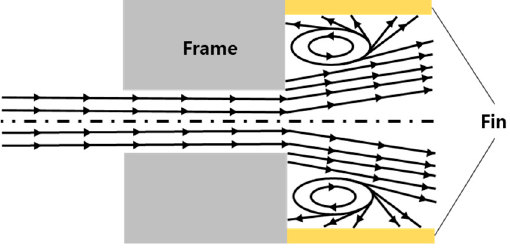
Figure 12. Schematic view of airflow around a diffuser [20].